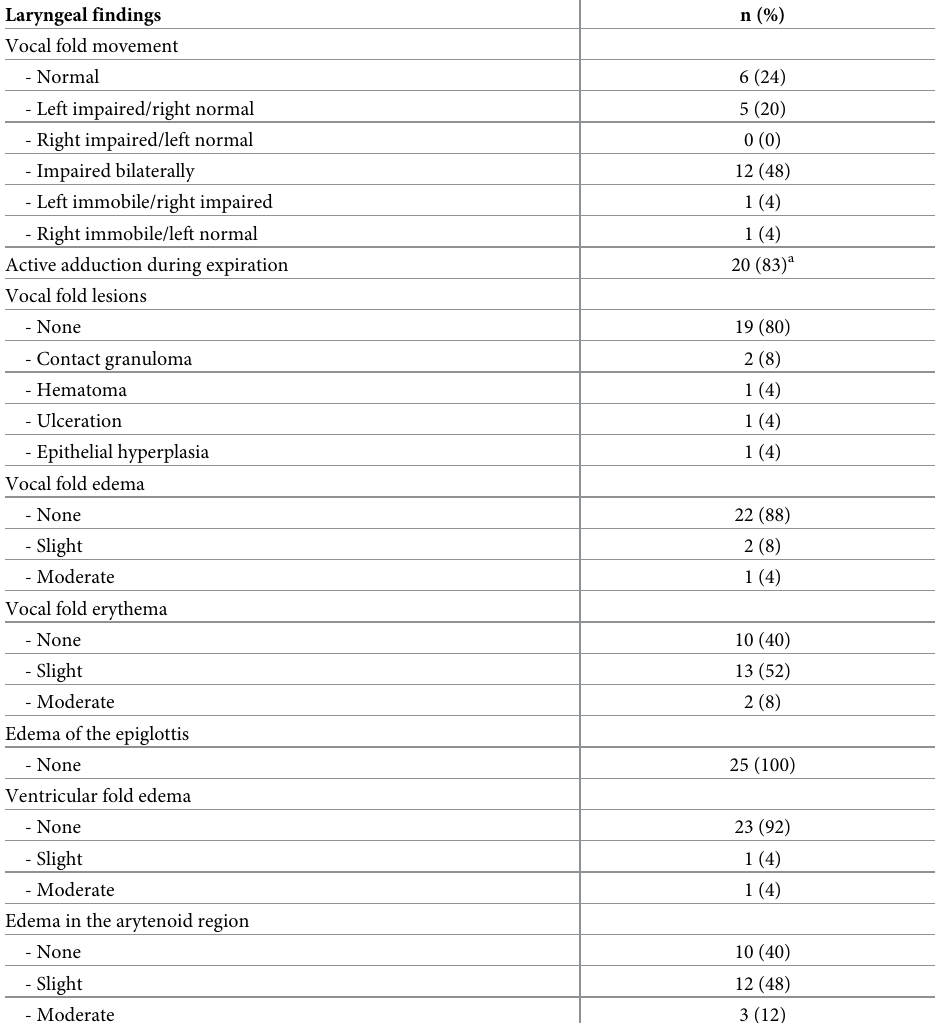
Table 4. Laryngeal